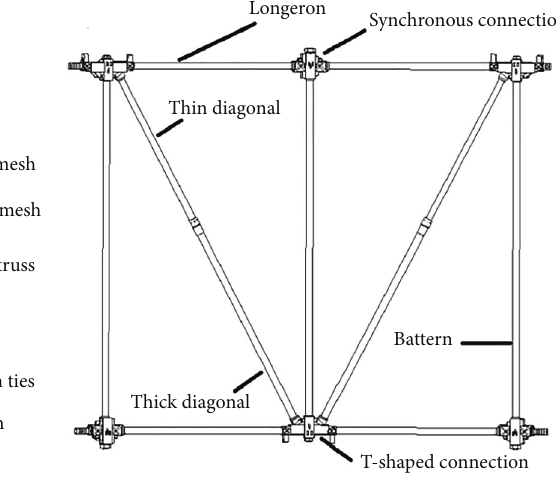
Figure 1: The composition of the ring deployable antenna.